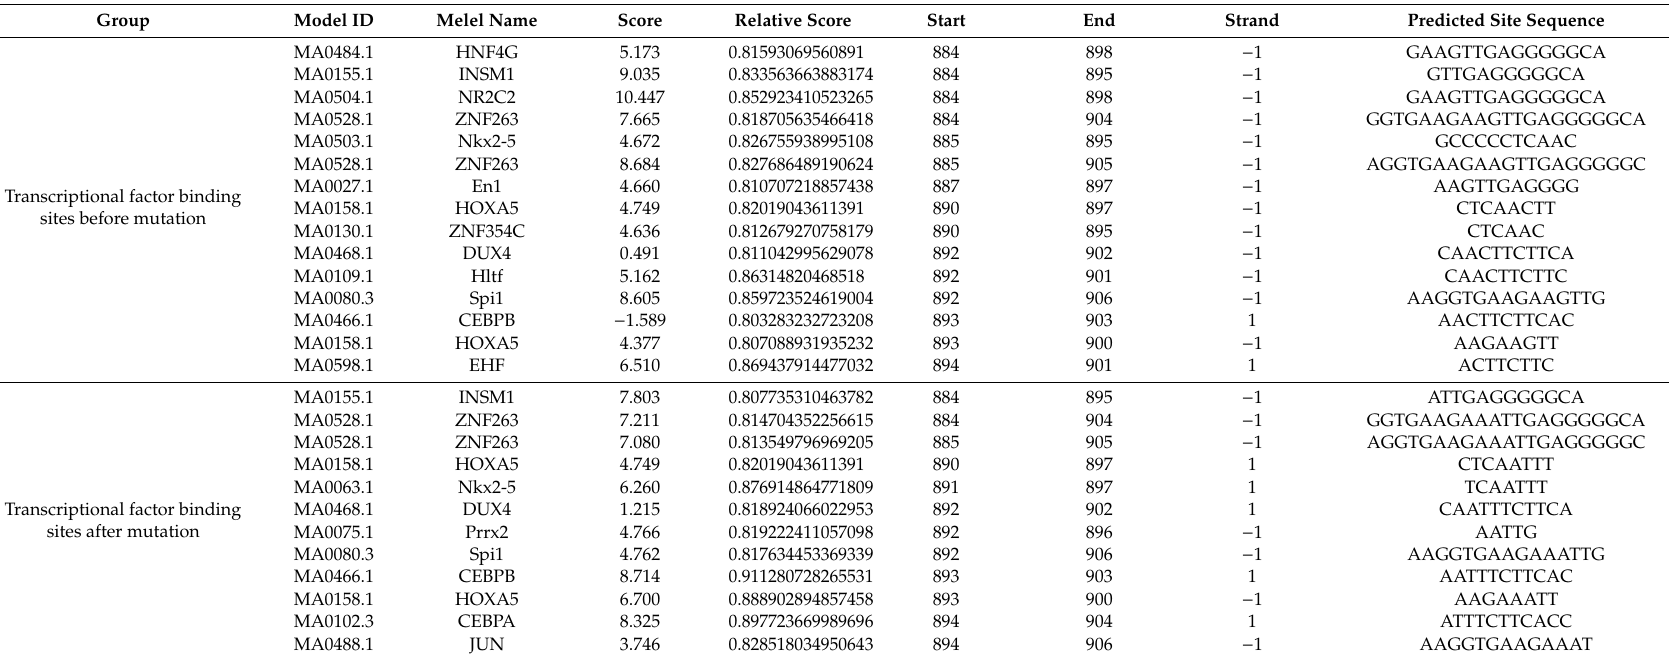
Table 3. Transcriptional factor binding prediction in the PDGF-D promoter region with mutation at g.3852134 C >